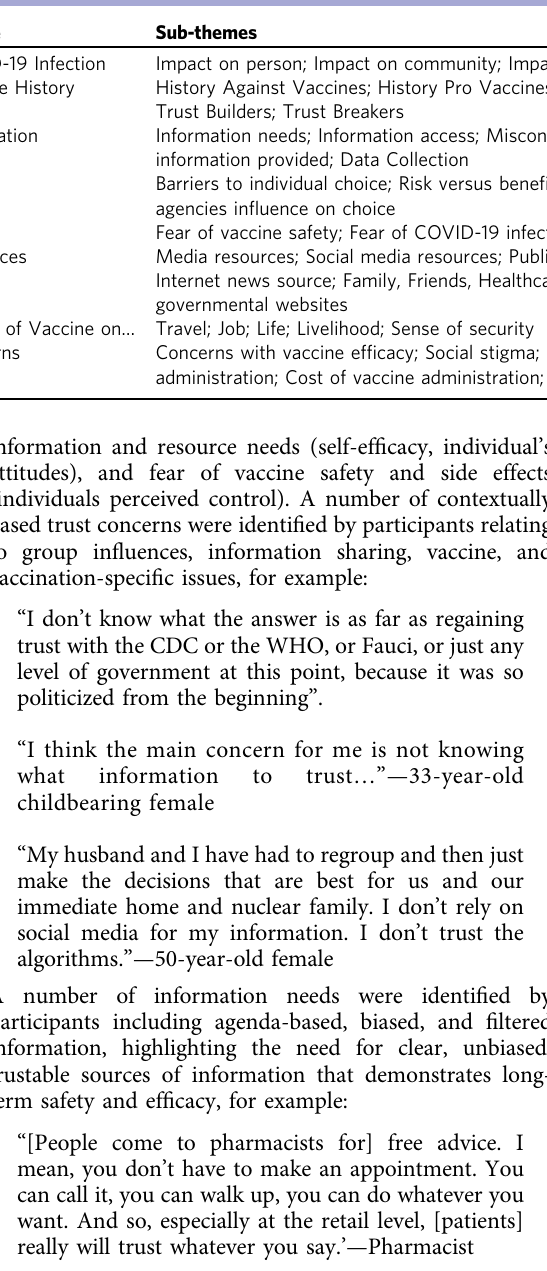
Table 1 Themes and